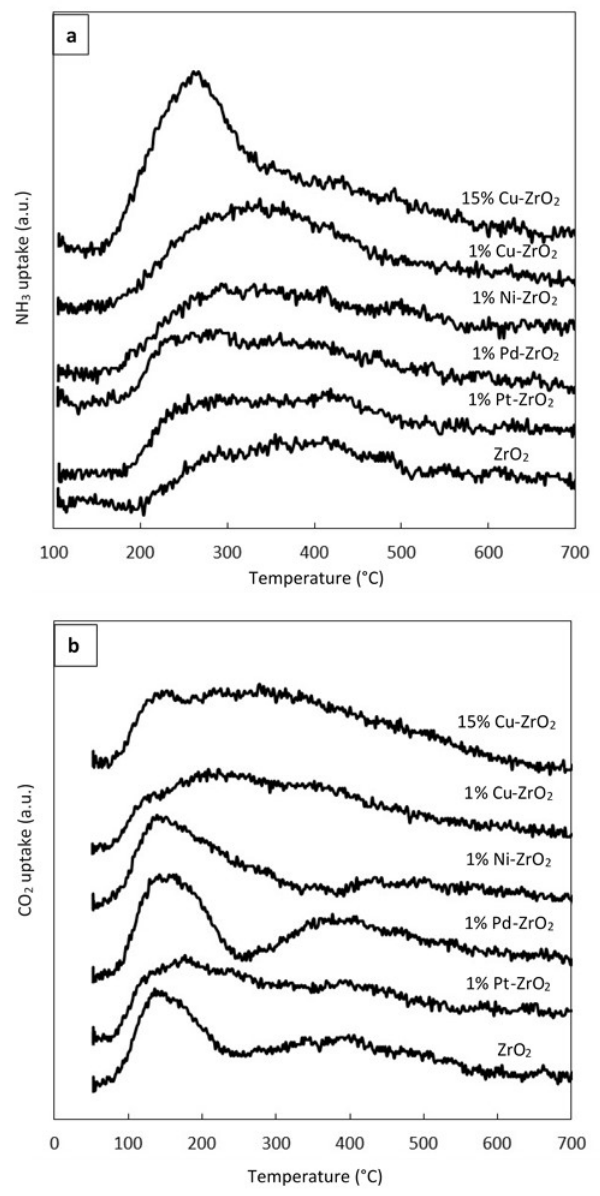
Figure 3. ( a ) NH 3 -TPD profiles of different catalysts; ( b ) CO 2 -TPD profiles of different